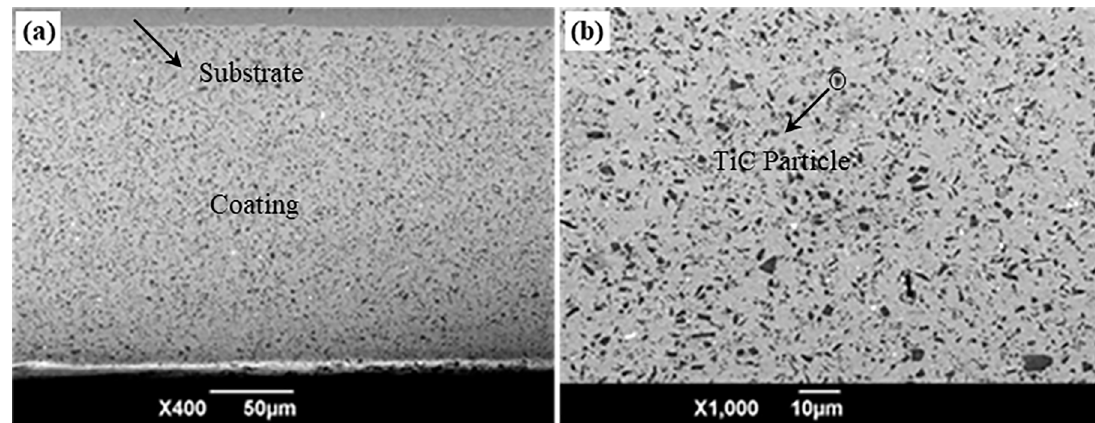
Figure 2. Cross-section SEM micrographs of Ni-TiC composite